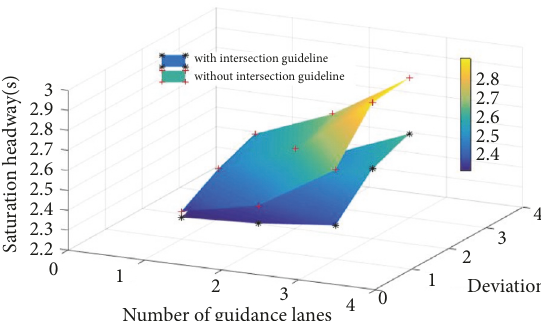
Figure 8: Comparison of saturation headways for left-turns. than the saturation headway of an intersection without guide line markings. On average, improvements of 10.3% can be obtained for left-turns. The results of the multifactor